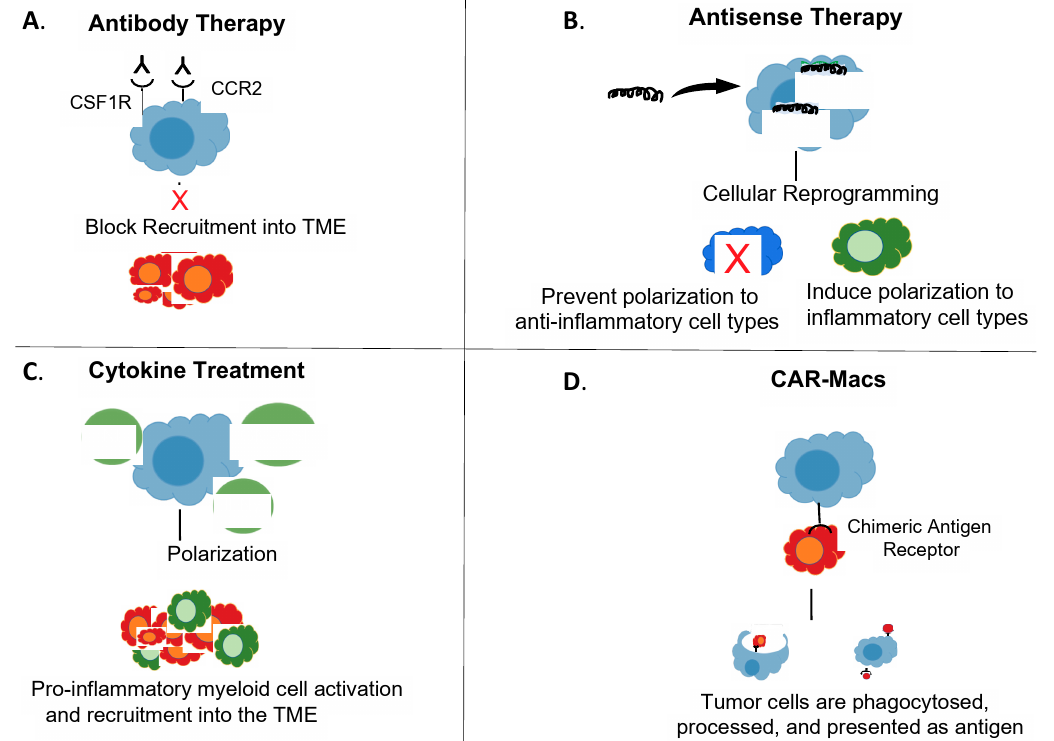
Figure 2. Targeting Myeloid Cell Populations in Cancer. Different approaches to target myeloid cells in cancer. ( A ) Examples of cell surface targets for antibody-based therapies. ( B ) Antisense oligonucleotide down-regulation of pro-tumorigenic signals. ( C ) Potential approaches with polarizing cytokine therapies. ( D ) Chimeric Antigen Receptor (CAR) Macrophages, analogous to CAR-T cells.